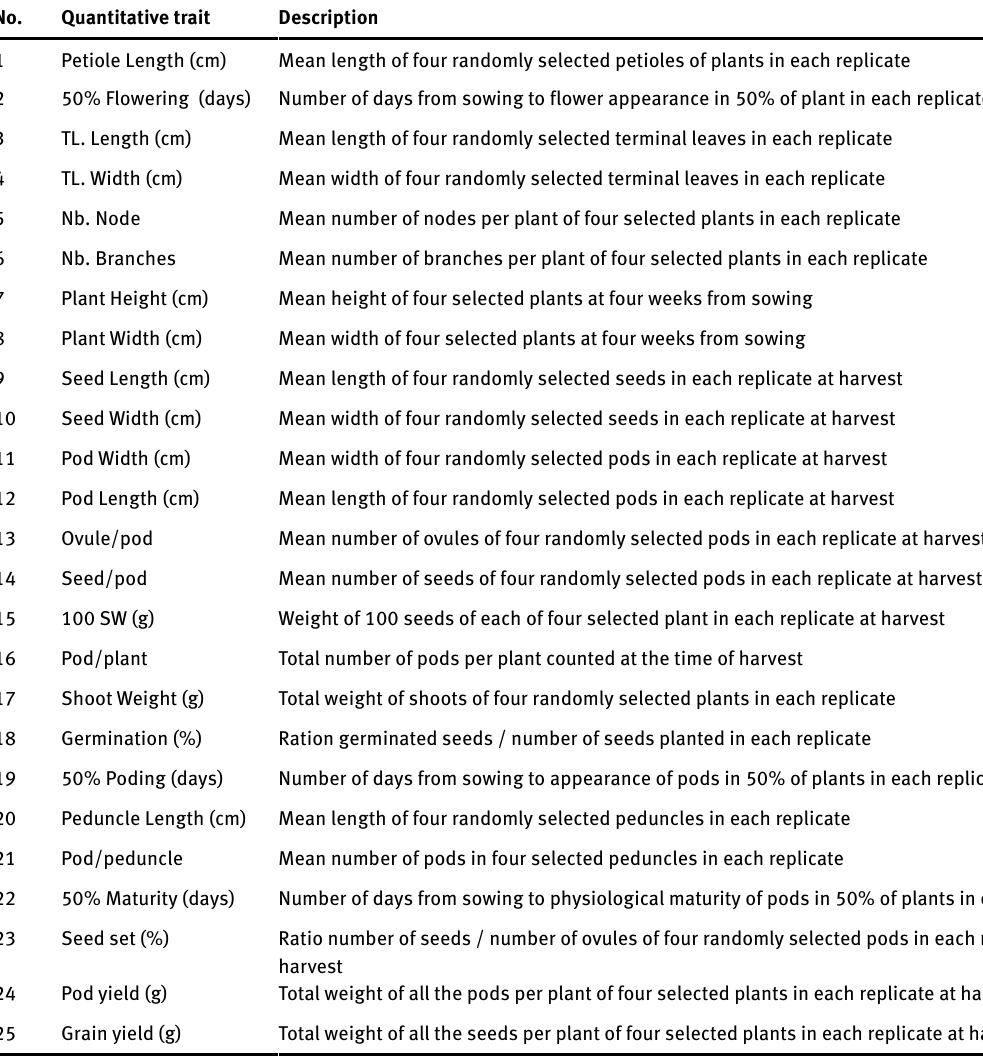
Table 2: List of quantitative traits and their descriptions No. Quantitative trait